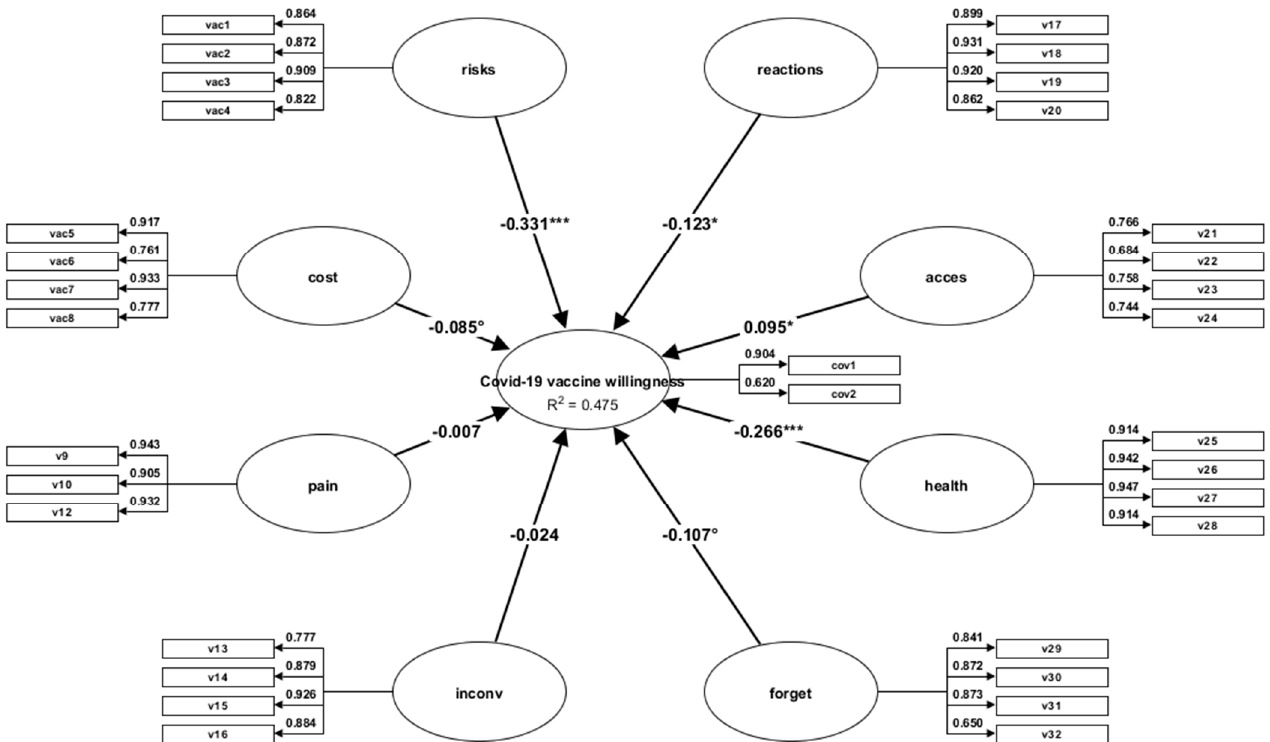
Figure 1. Variance-based structural equation modelling representing the MVHS prediction over anti-COVID-19 vaccine willingness; note: The figure shows the path ( β ) coefficients, which highlight the links between the structural model variables; v1 − v32 = MVHS items. * p < 0.05; *** p < 0.001.